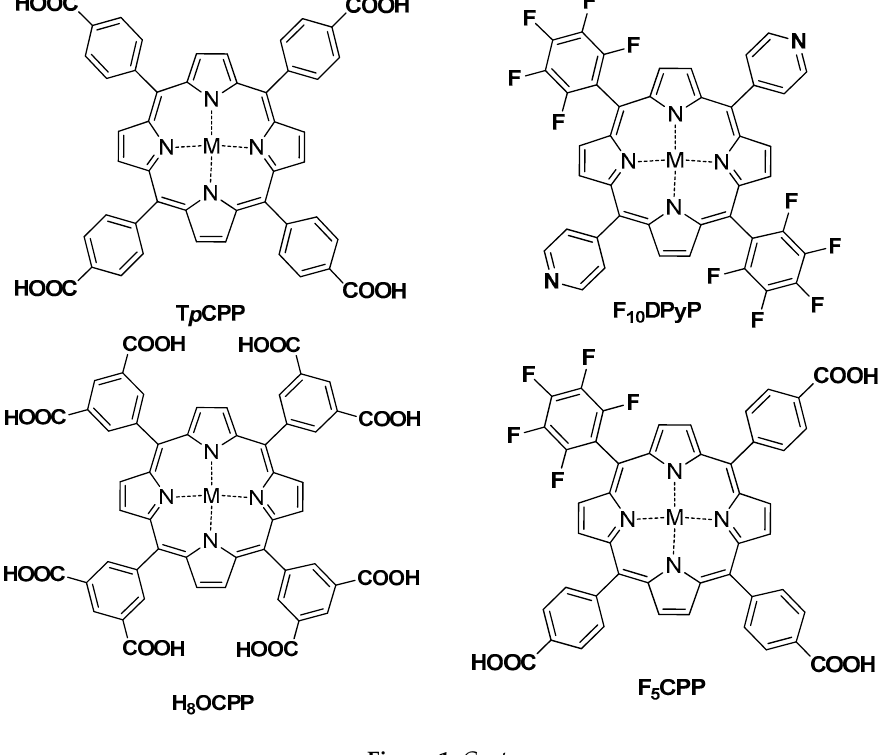
Figure 1 . Cont . Figure 1. Cont